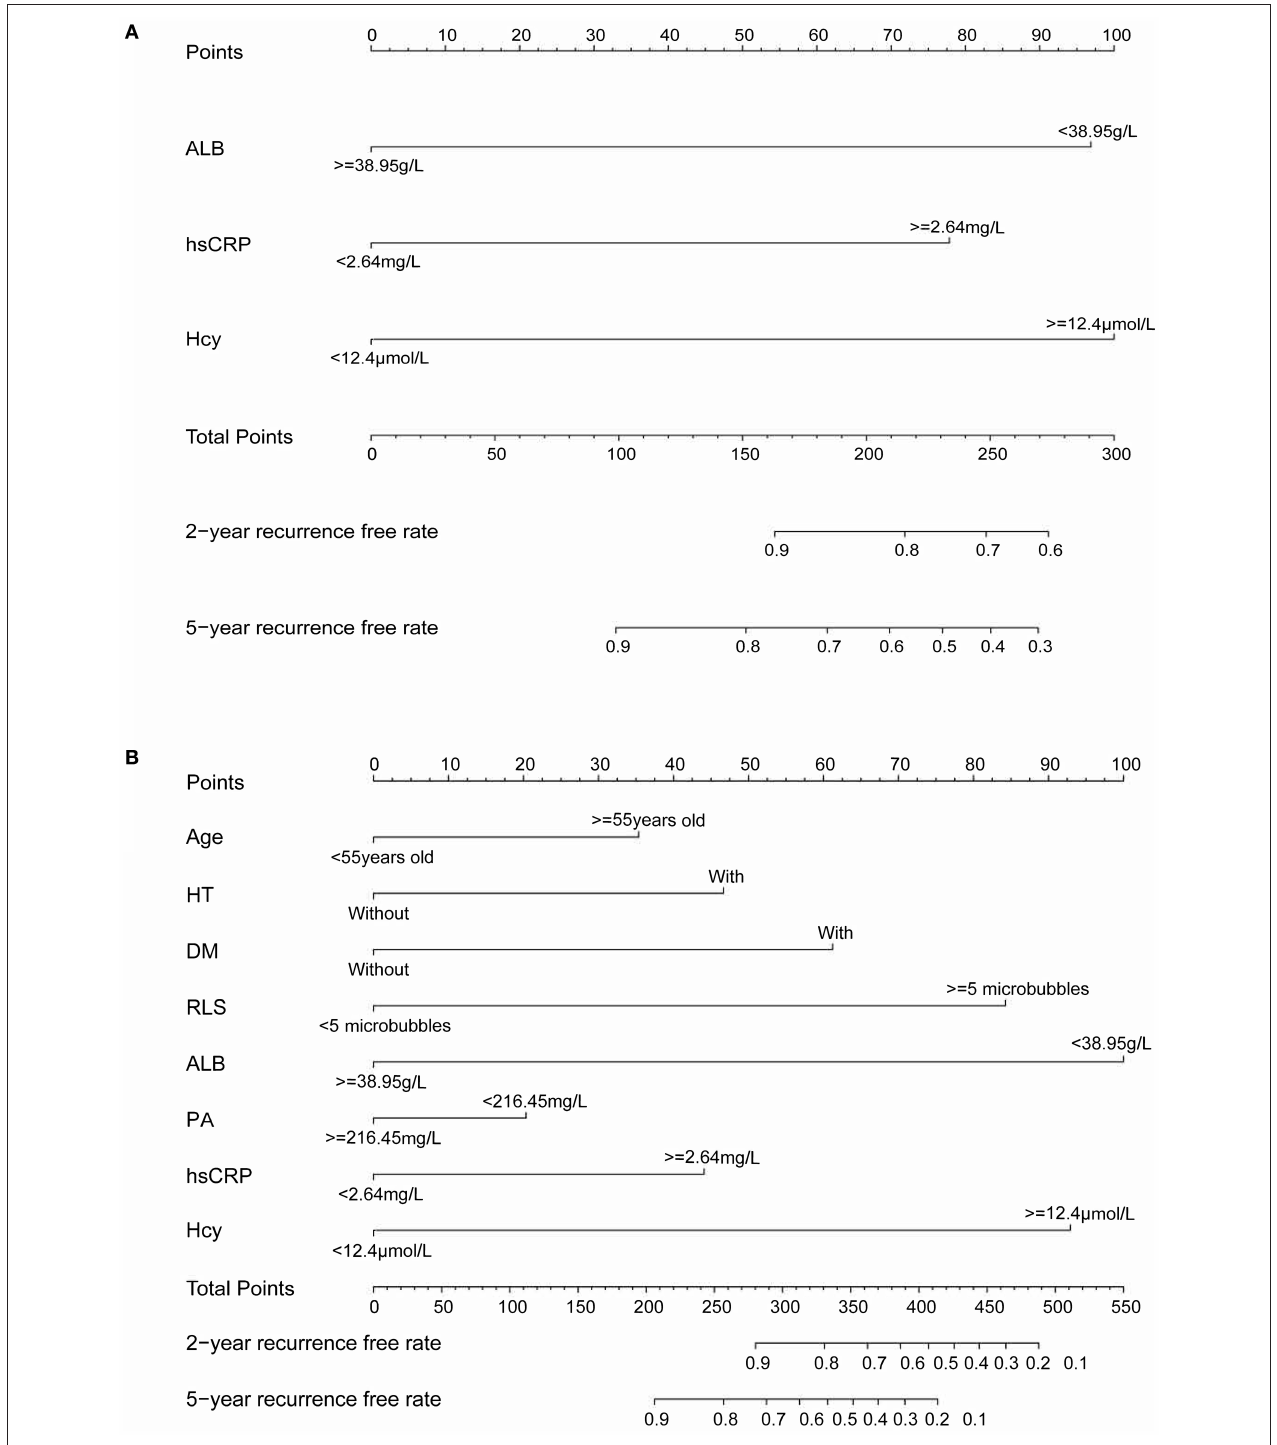
FIGURE 1 | (A) Nomogram 1 conducted by Cox regression, including Hcy, hsCRP, and ALB in patients with PFO-related stroke. (B) Nomogram 2 conducted by LASSO regression, including age, diabetes, hypertension, RLS, ALB, PA, hsCRP, and Hcy in patients with PFO-related stroke. Nomogram 1 and nomogram 2 are used to calculate the 2- and 5-year stroke recurrence-free rate. For an individual patient, each variable corresponds to a “Points” in the first row. The “Total Points” are summed up by all points and indicated in the third row from the bottom. Drawing a vertical line from “Total Points” to the first and second rows from the bottom will respectively show the 2- and 5-year recurrence-free